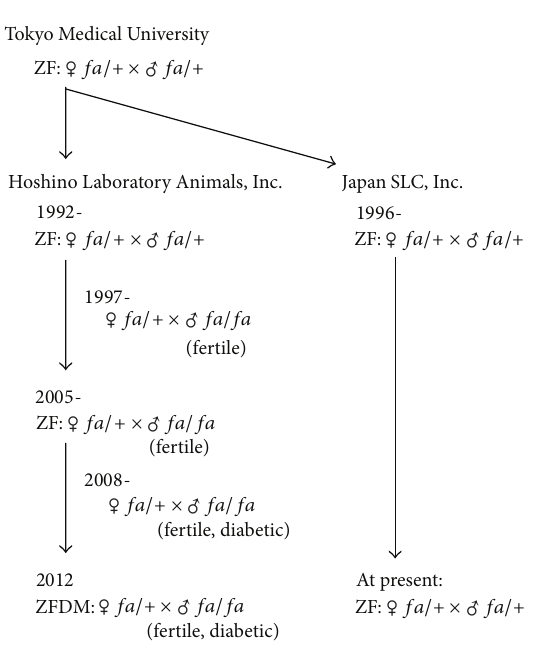
Figure 1: Establishment of a diabetic rat strain ZFDM from normoglycemic ZF